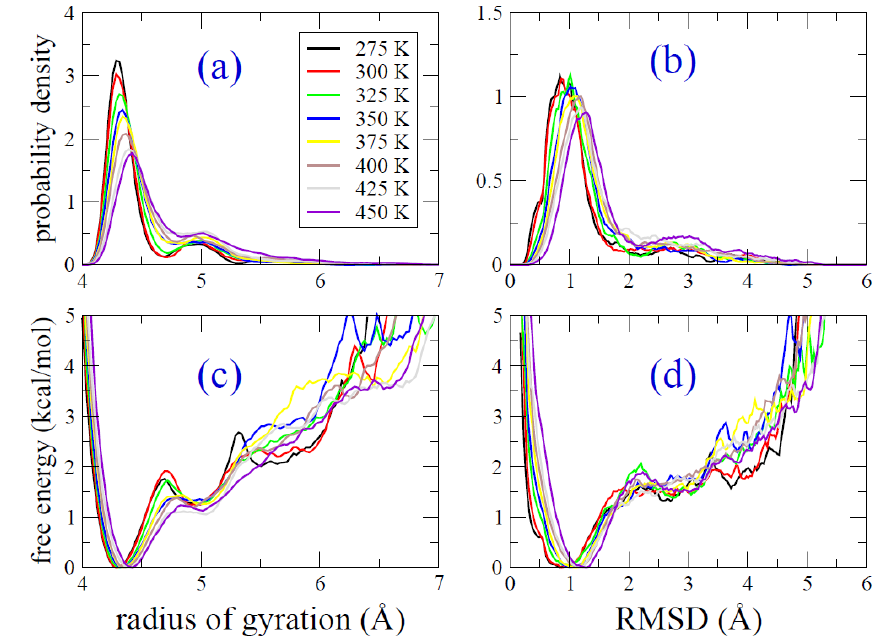
Figure 7. Distribution functions of the radius of gyration ( a ) and RMSD ( b ) obtained from REMD simulation are shown. Free energy functions in terms of the radius of gyration ( c ) and RMSD ( d ) are